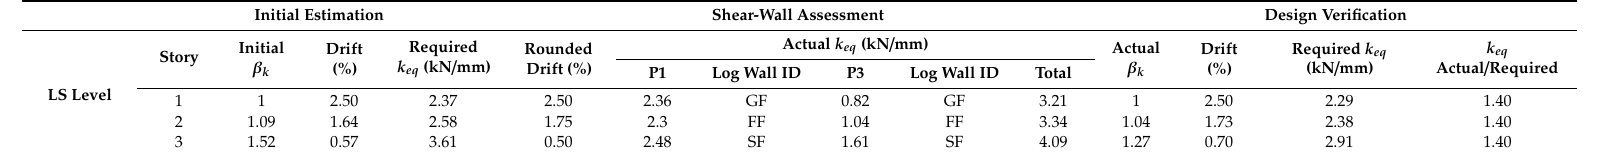
Table 5. Life Safety (LS) level analysis (X-direction), accounting for the EP shear-wall sti ff nesses.